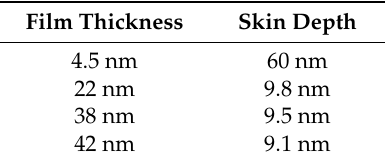
Table 2. Computed skin depth of a 500 nm incident electromagnetic